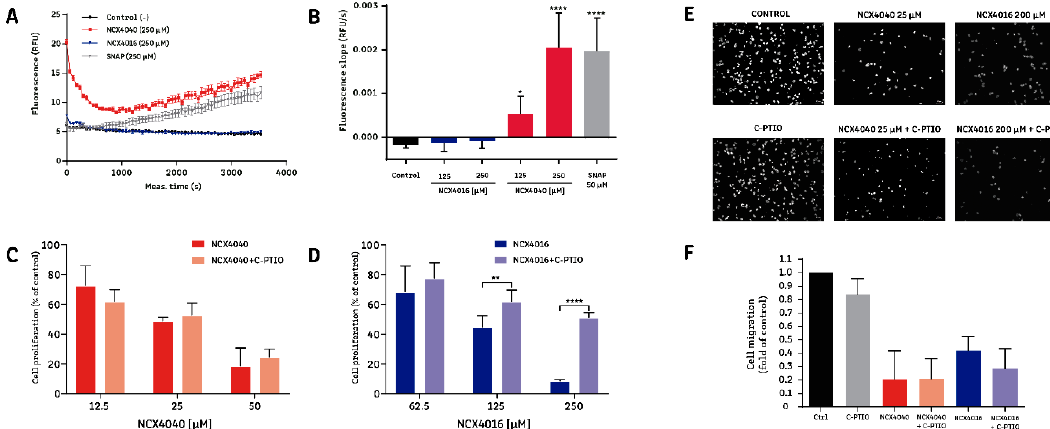
Figure 3. The relationship between nitric oxide (NO • ) release by NO-aspirins and their effects on non-small-cell lung cancer (NSCLC) cells. Intracellular NO • release by NO-aspirins was measured using a DAF-2 fluorescent probe. H1299 cells were pre-loaded with DAF-2 prior to incubation in culture plates. After 24 h, cells were exposed to the different drugs. Cell viability was measured by MTT reduction. Cell migration was evaluated using an 8 µM-pore cell culture insert and fluorescence microscopy. ( A ) Representative graph showing the relative fluorescence induced by NO • release from NO-aspirins. ( B ) Slope of fluorescence over time, induced by NO • release from NO-aspirins. SNAP was used as a positive control for NO • release. * p < 0.05 and **** p < 0.00001, compared with the negative control, calculated by one-way ANOVA and Dunnett’s post-test. ( C ) Cell proliferation after exposure of H1299 cells to NCX4040 and NCX4040 + C-PTIO for 96 h. ( D ) Cell proliferation after exposure of H1299 cells to NCX4016 and NCX4016 + C-PTIO for 96 h. ** p < 0.01 and **** p < 0.00001, between the indicated groups, calculated by one-way ANOVA and Tukey post-test. ( E ) Representative images of H1299 cell migration following exposure to NO-aspirins alone or in the presence of C-PTIO. ( F ) Quantitation of migration of H1299 cells exposed to NO-aspirins alone and in the presence of C-PTIO. Bar graphs summarize the results of at least three independent experiments.